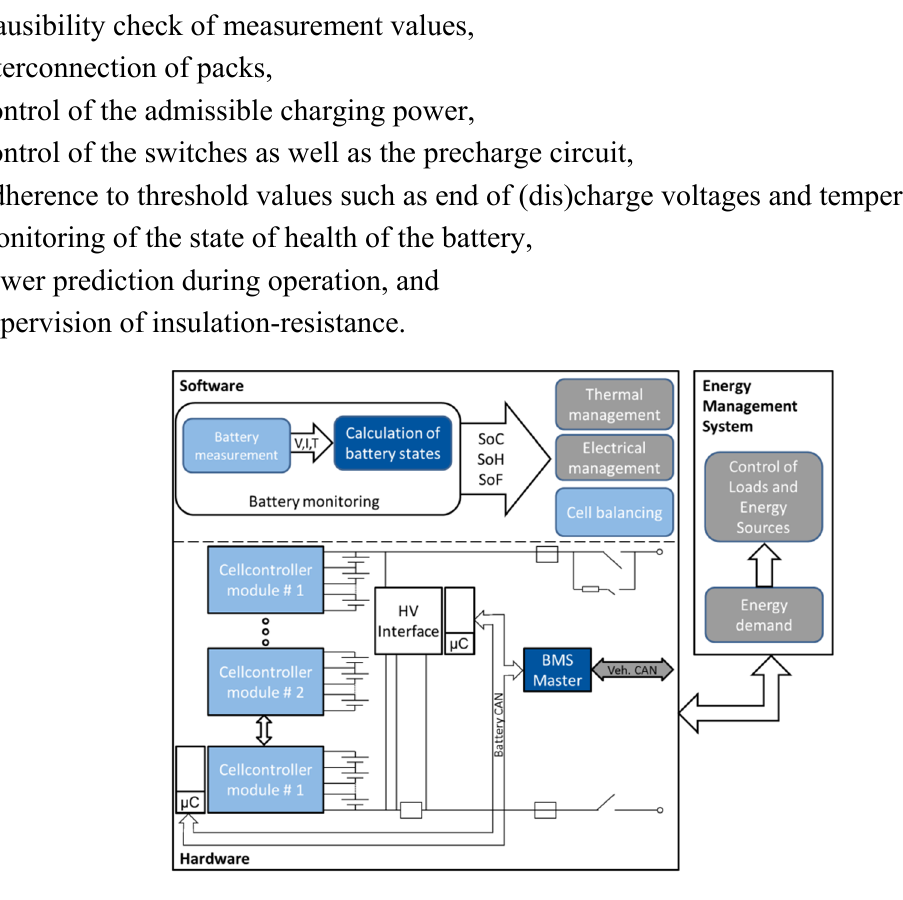
Figure 10. Structure of the battery management system on software and hardware